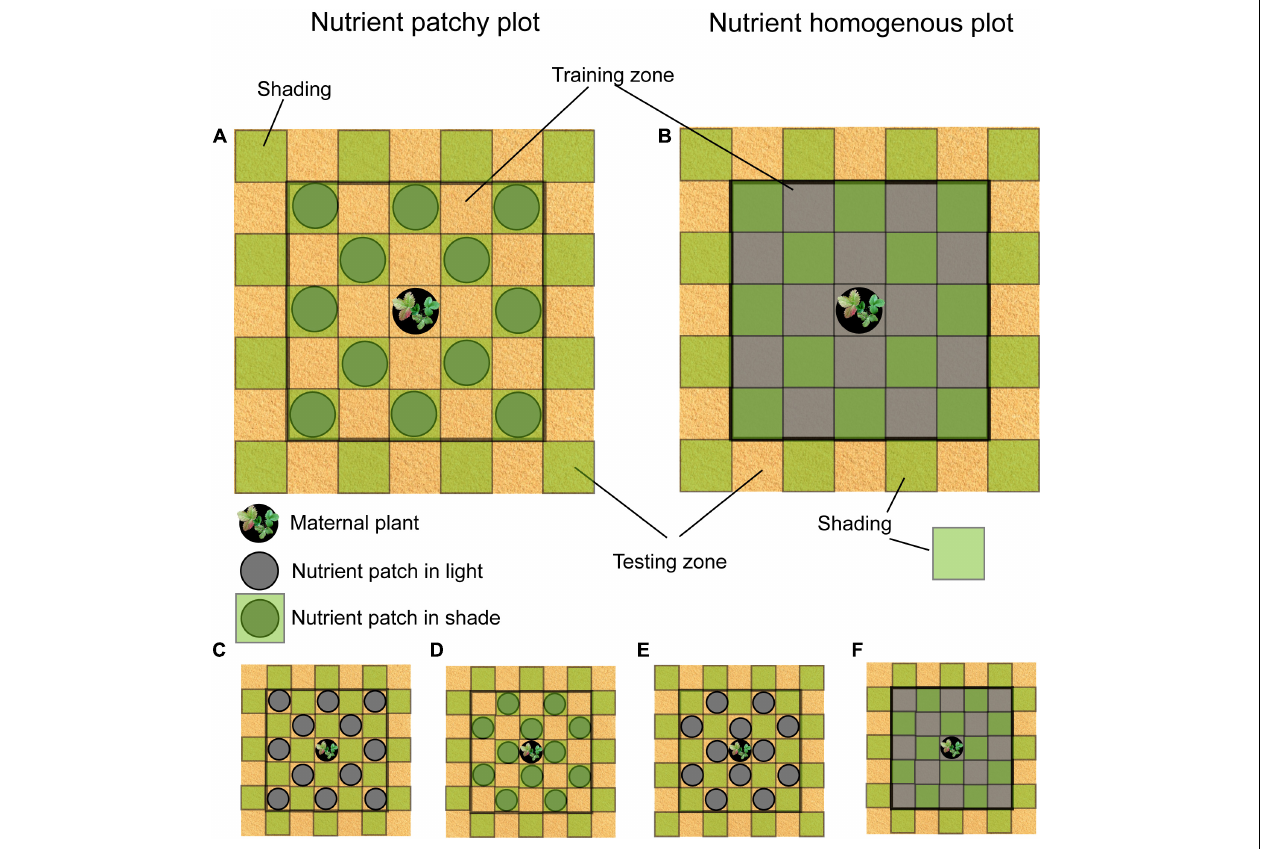
FIGURE 1 | Scheme of the study design. Circles represent nutrient patches. Green squares represent shading by the textile. (A) Nutrient patches in shade, light patches in a cross pattern. (B) Nutrient homogenously distributed, light patches in a cross pattern. (C) Nutrient patches in full light, light patches in a diagonal pattern. (D) Nutrient patches in shade, light patches in a diagonal pattern. (E) Nutrient patches in full light, light patches in a cross pattern. (F) Nutrient homogenously distributed, light patches in a diagonal pattern.